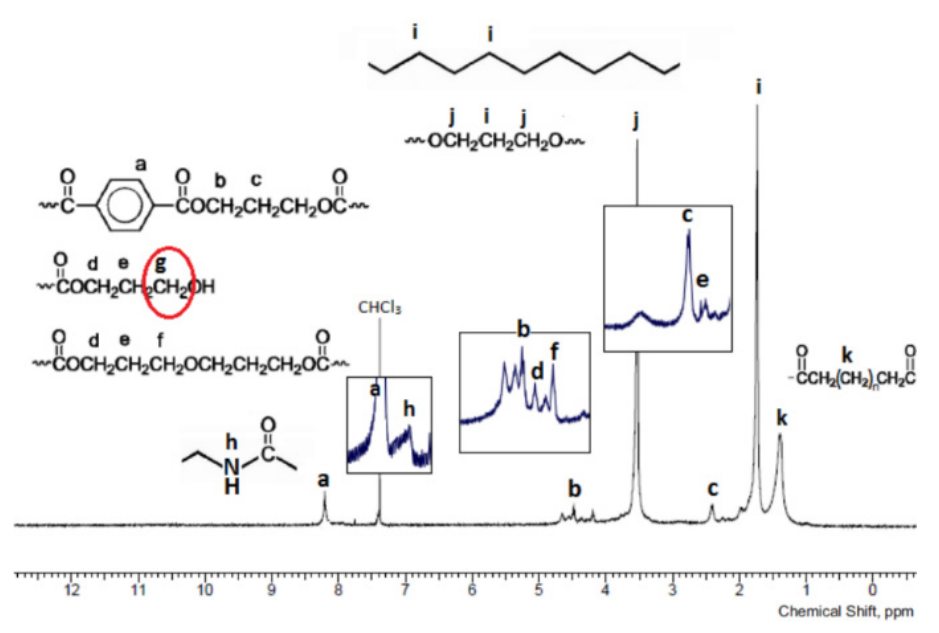
Figure 7. 1 H NMR spectra of terpolymer 3GT-PTMO-PA12.